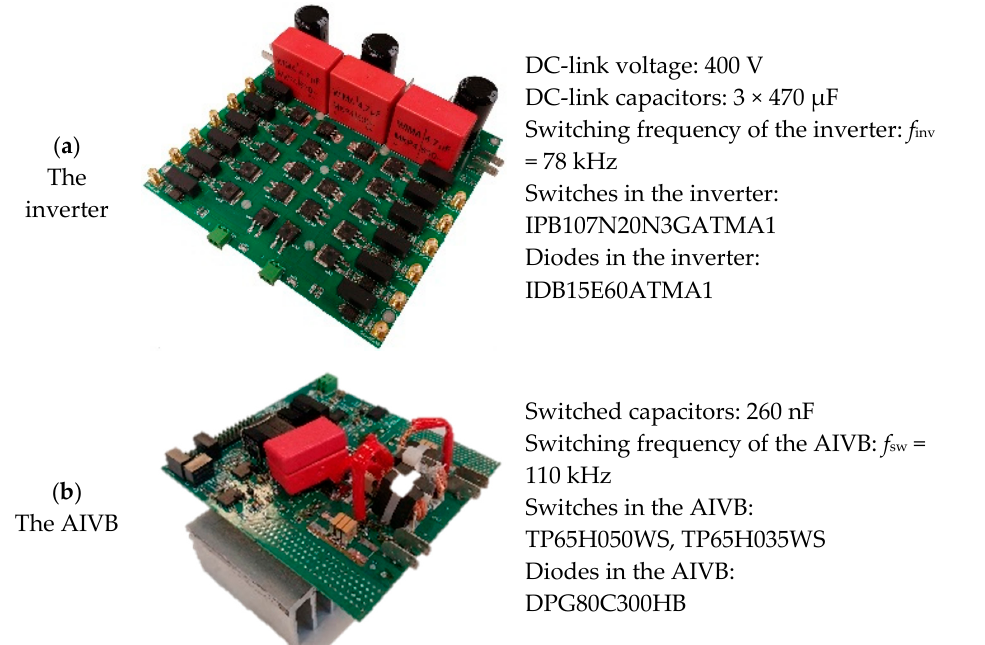
Figure 20. Components of the experimental setup: ( a ) the inverter and ( b ) the AIVB. The main parameters of the converters.